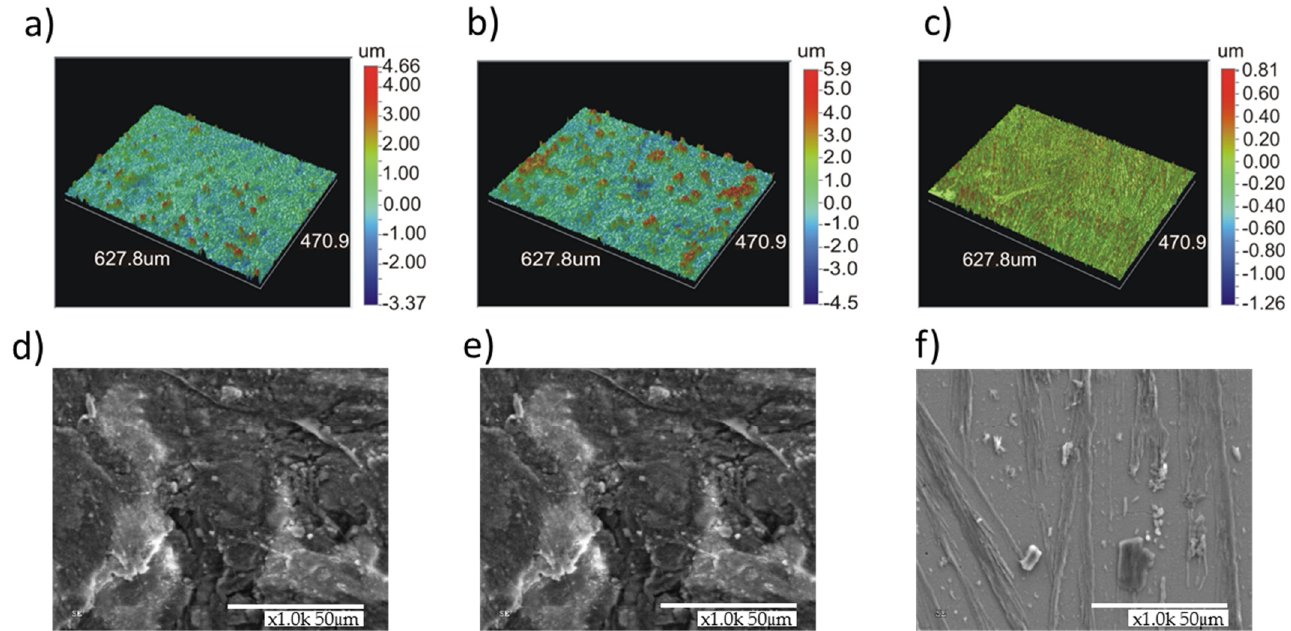
Figure 5. Surface morphology images performed by a laser profilometer and SEM images of Fe-1% Cr ( a , d ), Fe-3% Cr ( b , e ) and Fe-5% Cr ( c , f ) alloys after chronoamperometric measurements at a constant potential ( E vs. SHE = − 0.5 V) in 0.1 M Na 2 SO 4 at 80 °C.